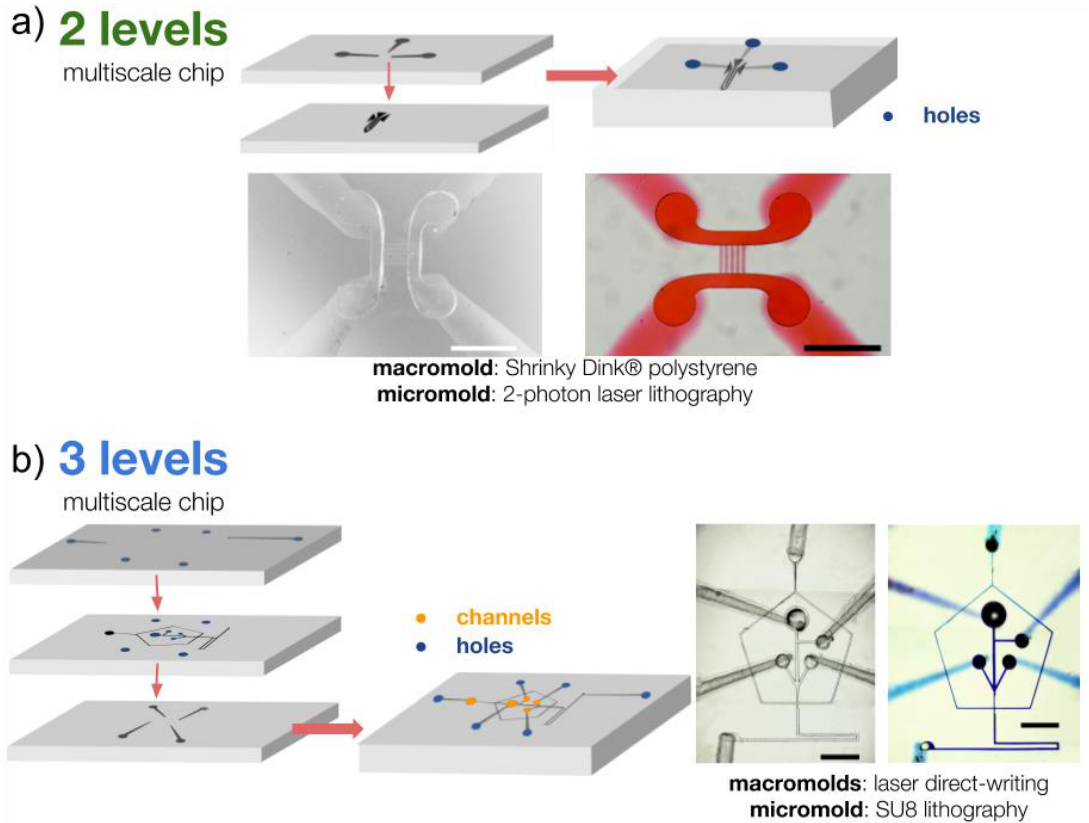
Figure 4. Examples of common microfluidic chips and platforms fabricated using our micro–macro process with multiple molds. ( a ) 2-level chips with one low-resolution mold and one high-resolution mold replicated in PDMS and bonded together aligning the channels interconnects before testing the flows. ( b ) Microdroplets chip fabricated to demonstrate the possibility to align and interconnect 3 microfluidics levels in one single chip. Scale bars: 500 µm.